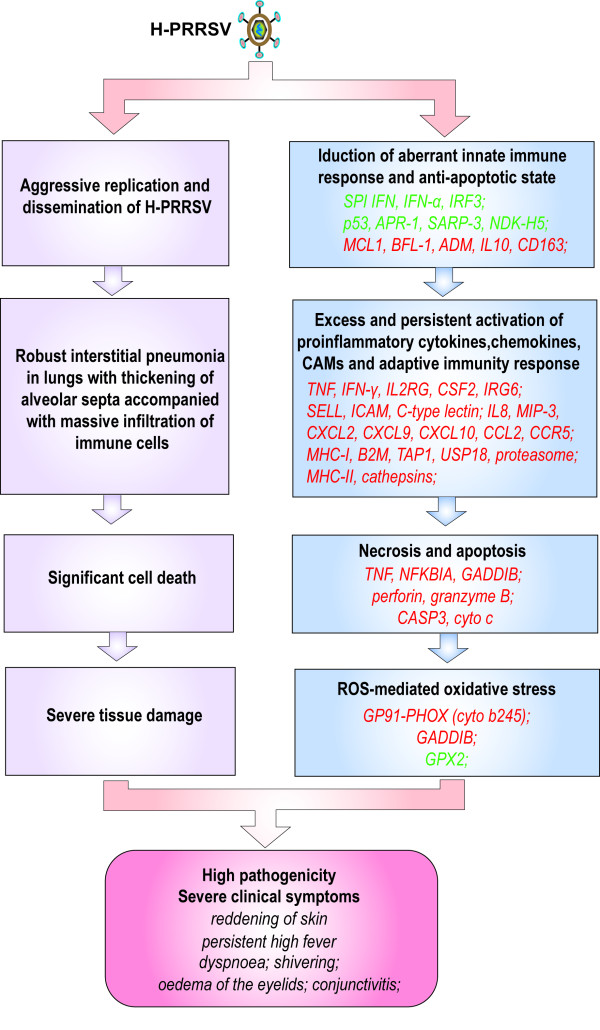
Model of the relationship between pulmonary gene expression profiles and infection pathology. Genes shown in red were up-regulated and those shown in green were down-regulated in infected pigs relative to C pigs (See Additional file 2 for full gene names).